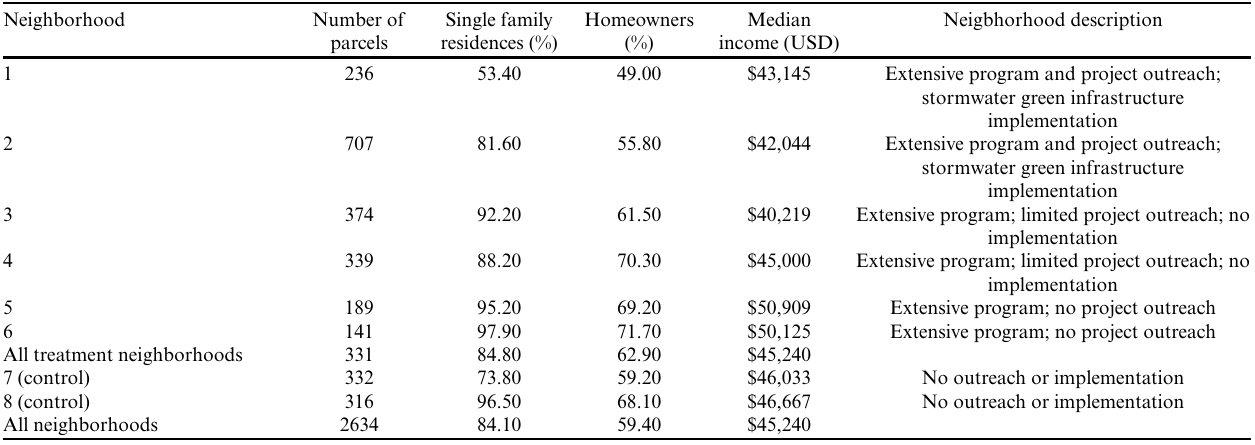
Table 1. General characteristics of the six treatment and two control neighborhoods.